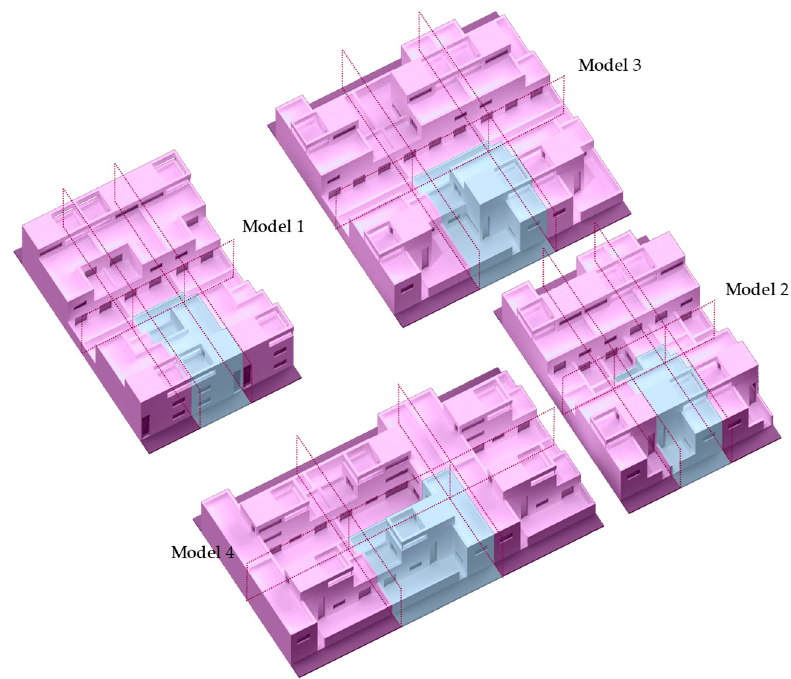
Figure 2. Three-dimensional (3D) Simulation of the block configuration from the dwelling unit for Models 1 − 4.